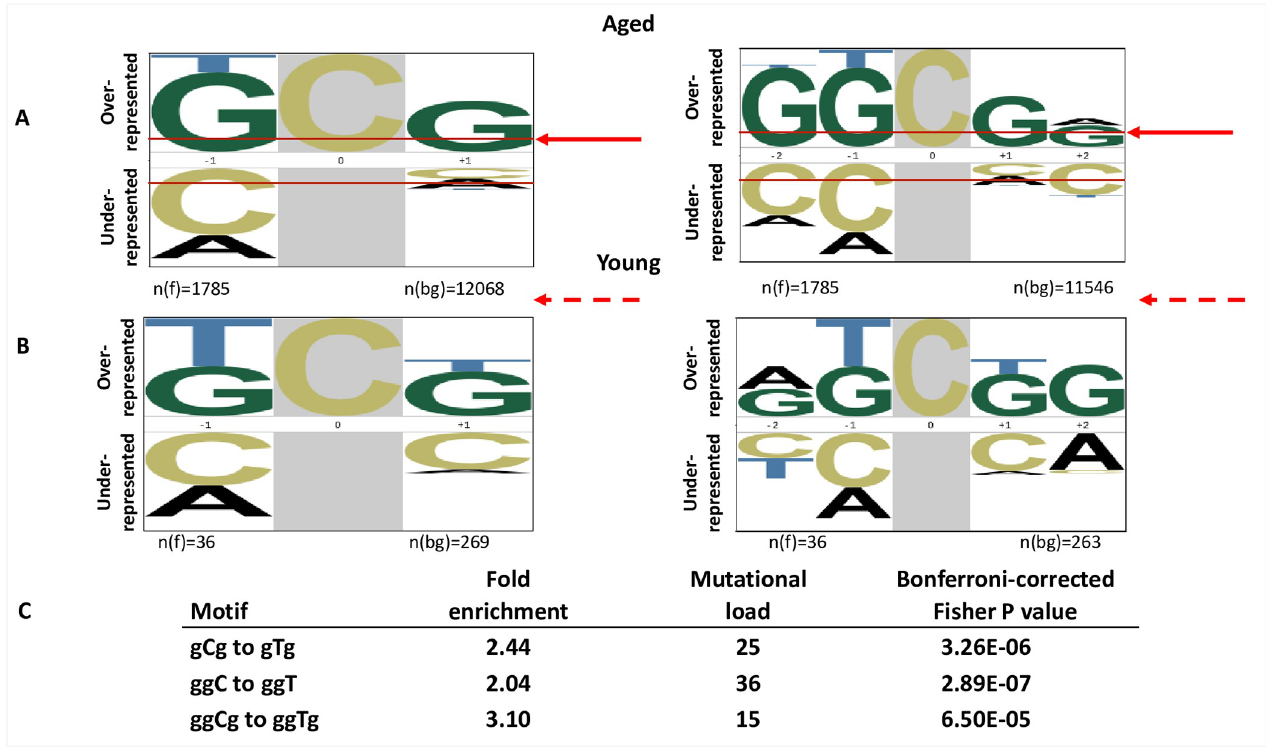
Fig 8. Signature of aging in human mtDNA. A. Overrepresented nucleotides in tri- (left) or pentanucleotide (right) motifs flanking CG to TA transitions, comprising the majority of substitutions in mtDNA in the brains of aged individuals [21] identified by pLogo analysis [40]. The height of each letter indicates the magnitude of over- or underrepresentation. The analysis was based on combined data for C to T substitutions in mitochondria of four aged individuals. The background data set is +/ − 20 nucleotides adjacent to the mutation site. The enrichment for the nucleotides above the red arrows is statistically significant, P < 0.05. B. pLogo analysis of CG to TA substitutions in mtDNA in the brains of young individuals. The foreground n (fg) = 36 is the number of all C to T substitutions in the analyzed mitochondrial sequences. The background data set is +/ − 20 nucleotides adjacent to the mutation site. Dashed red arrows above the sequence indicate that none of the adjacent nucleotides are significantly enriched. C. Fold enrichment for specific motifs calculated independently by in- house pipeline (Materials and methods and [13]). The mutated residue and resulting change are capitalized. mtDNA, mitochondrial DNA.